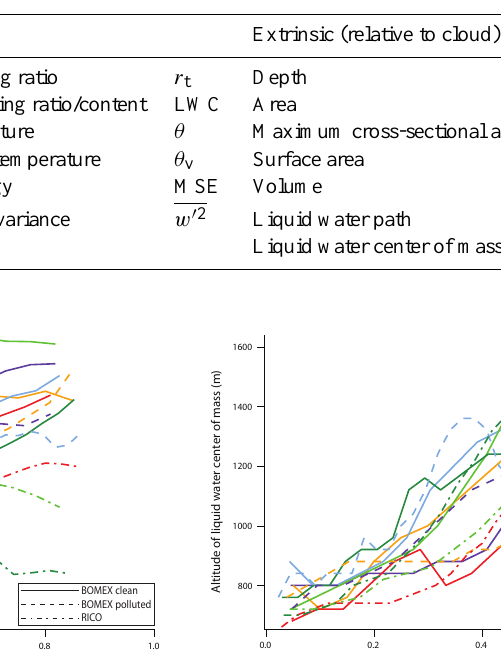
Table 2. Intrinsic and extrinsic variables examined.